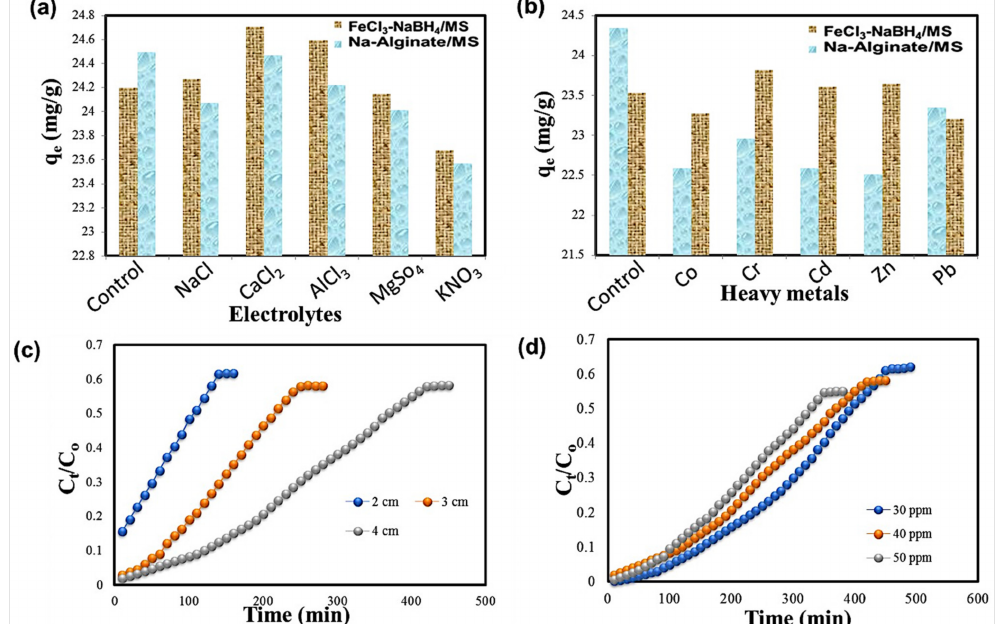
Figure 5. ( a ) Effect of different electrolytes, ( b ) effect of various heavy metals towards adsorption performance of 2,4,6-TCP onto FeCl 3 -NaBH 4 /MS and Na-Alginate/MS composites, and ( c , d ) effect of bed height on the uptake of 2,4,6-TCP by the FeCl 3 -NaBH 4 /MS hybrid